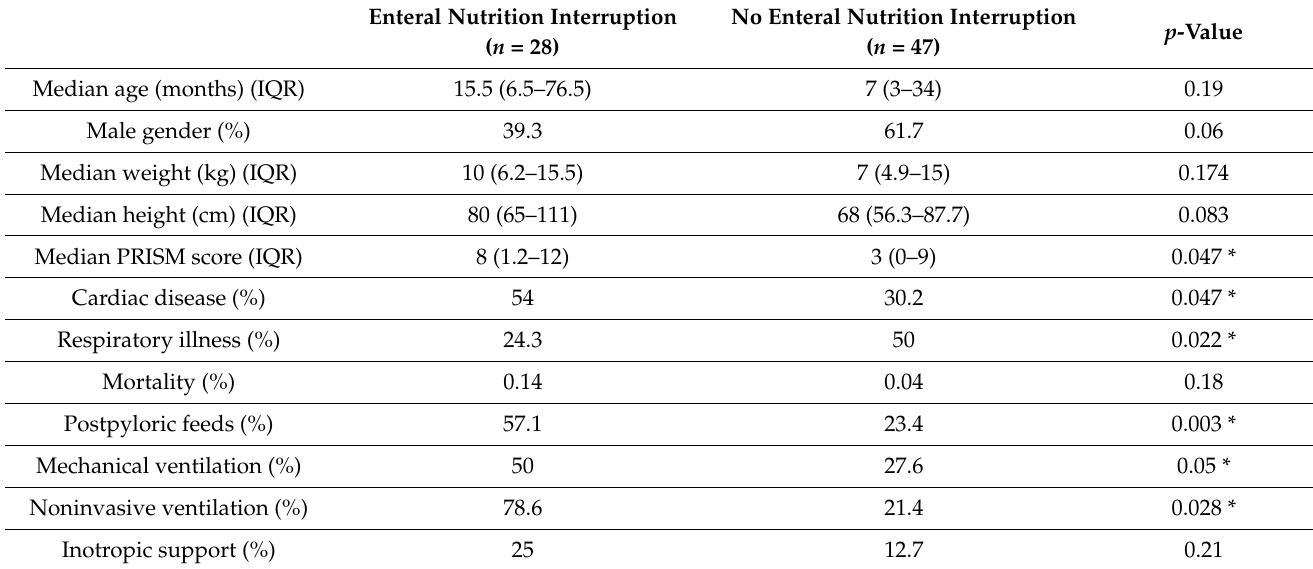
Table 1. Comparison of patients with any EN interruption versus those without